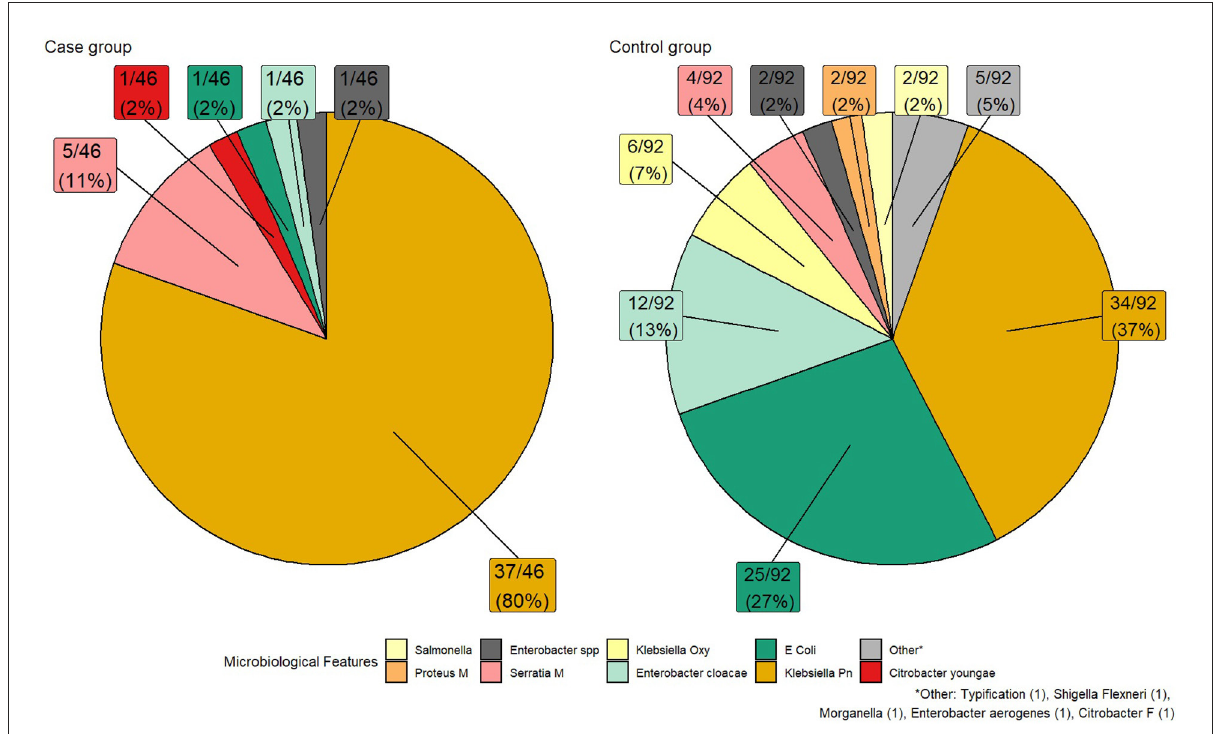
FIGURE1 Bacterial distribution and resistance mechanism in cases vs